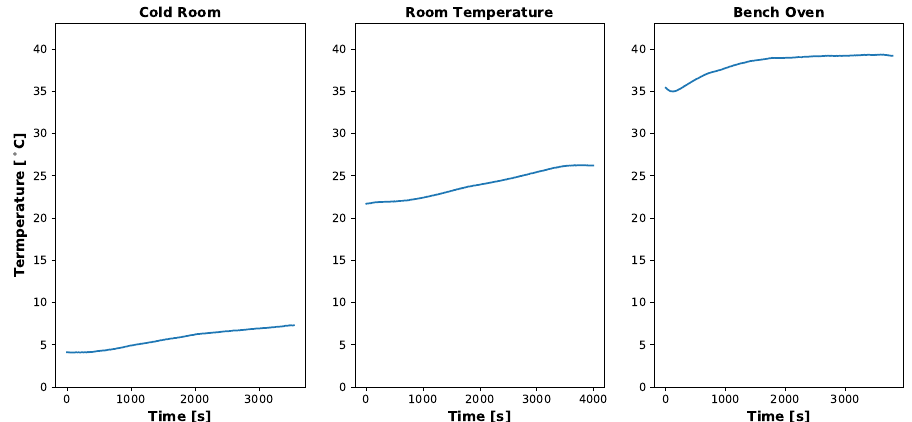
Figure 10. Temporal temperature profile during MicaSense RedEdge-M dark current testing. Temperature inside light tight bag did rise as test progressed but no significant changes in the digital counts were noticed. Data collection took about an hour for each temperature setting because the gain and exposure time were altered programatically using the RedEdge Application Program Interface